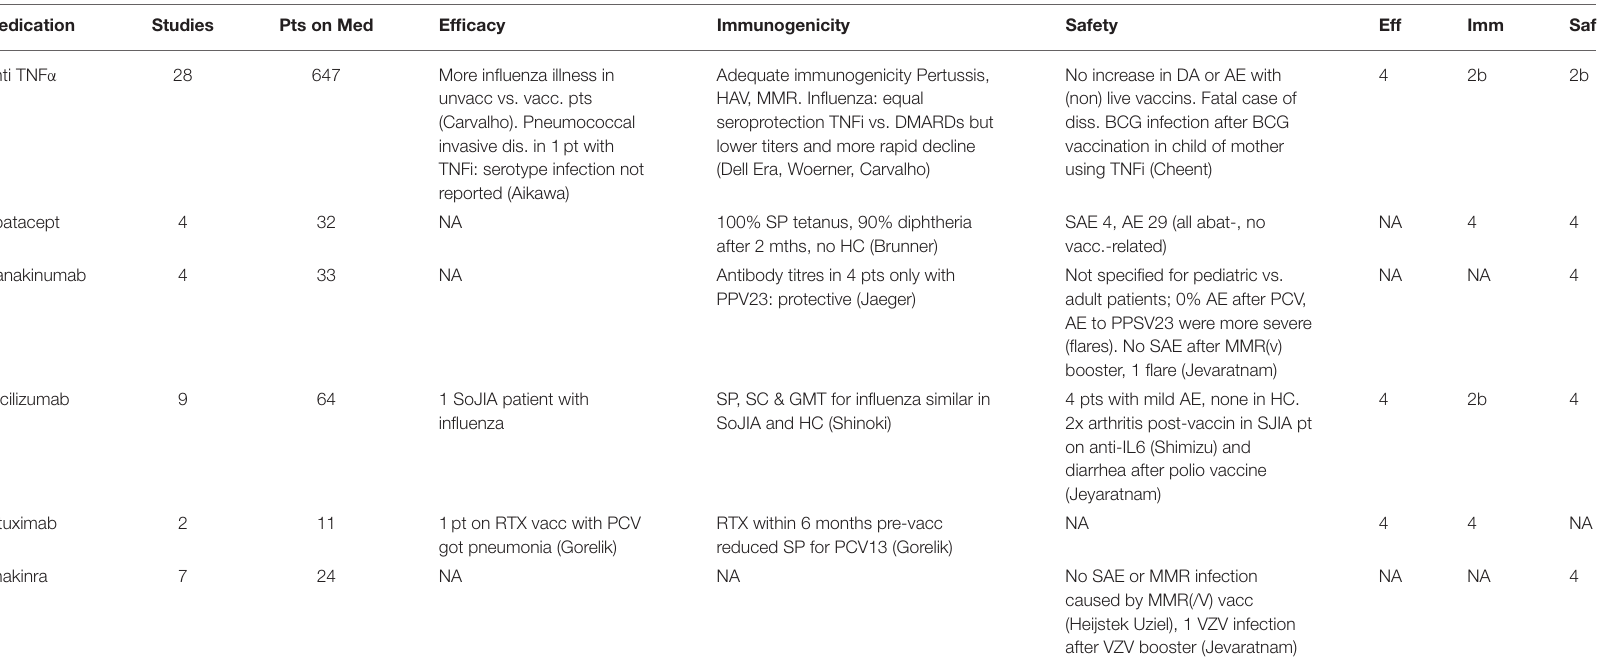
LoE, level of evidence; Eff, Efficacy; Imm, immunogenicity Saf, Safety; NA, not analyzed; SP, seroprotection; SC, seroconversion; GMT, geometric mean titer; HC, healthy controls; pts, patients; DTP, diphtheria tetanus pertussis; IBD, inflammatory bowel disease; TNFi, tumor necrosis factor inhibitor; AE, adverse event; SAE, severe adverse event; SO, systemic onset; JIA, juvenile idiopathic arthritis; jSLE, juvenile systemic lupus erythematosus; bDMARD, biological disease modifying anti-rheumatic drugs; ABT, abatacept; TT, tetanus toxoid; MV, measles vaccine; RTX, rituximab; vacc, vaccine; AB, antibody; HAV, hepatitis A virus; HBV, hepatitis B virus; ETN, etanercept; ADA, adalimumab; TCZ, tocilizumab; IFX, infliximab; MMR(/V), measles mumps rubella (/varicella); VZV, varicella zoster virus; ANR, Anakinra; CAM, canakinumab; CAPS, cryopyrin-associated periodic